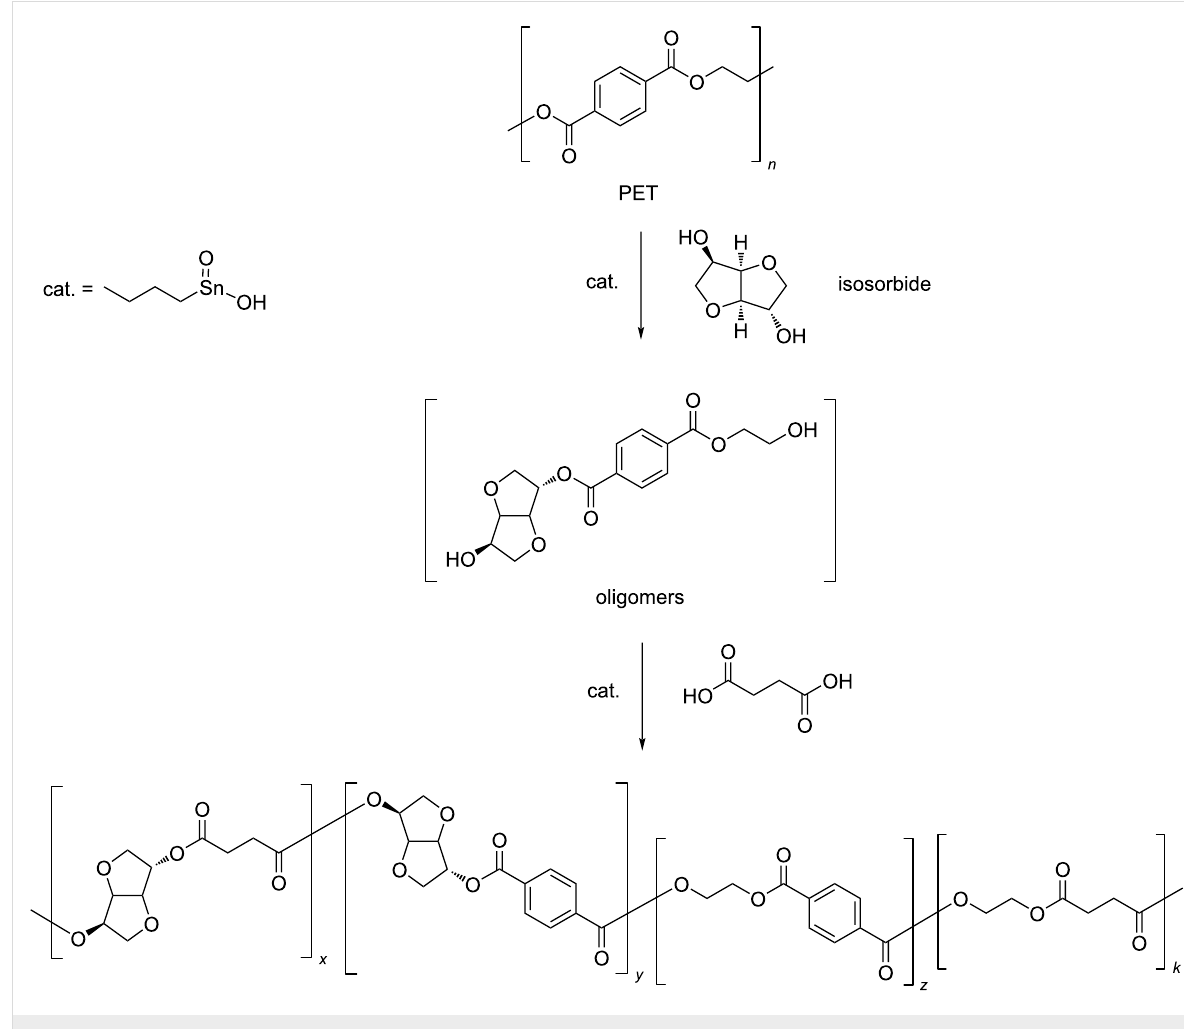
Scheme 7: One-pot, two-step process for PET repurposing via chemical recycling.